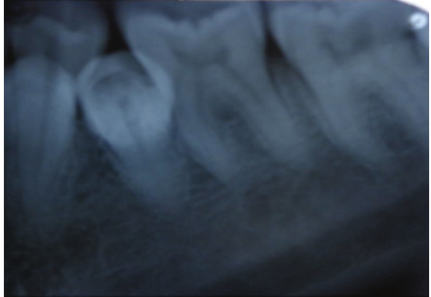
Figure 3: Intraoral periapical radiograph of the supernumerary